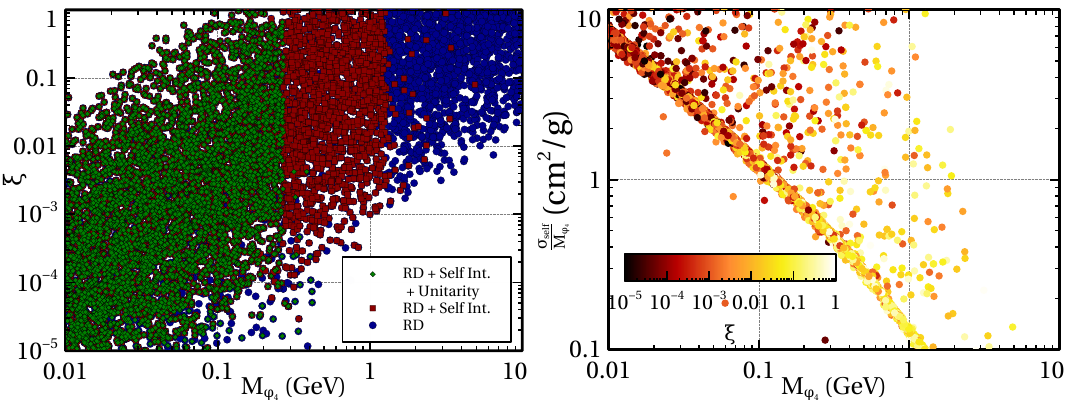
plane for different constraints. Right 4